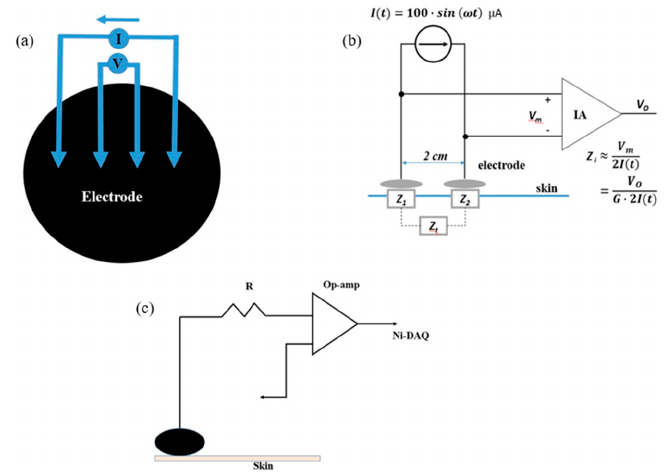
Figure 2. The experimental set up for ( a ) the surface resistivity, ( b ) skin impedance, and ( c ) direct current (DC) offset potential.